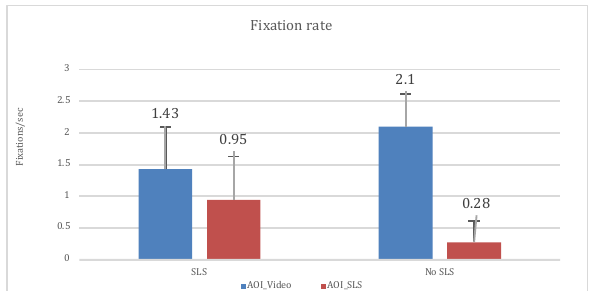
Figure 8: Interaction effect of fixation rate across AOIs. The error bar indicates the standard deviation.